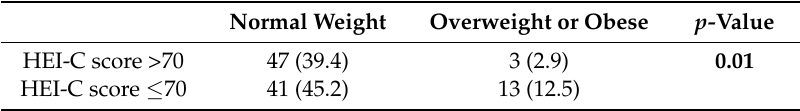
Results are presented as follows: n